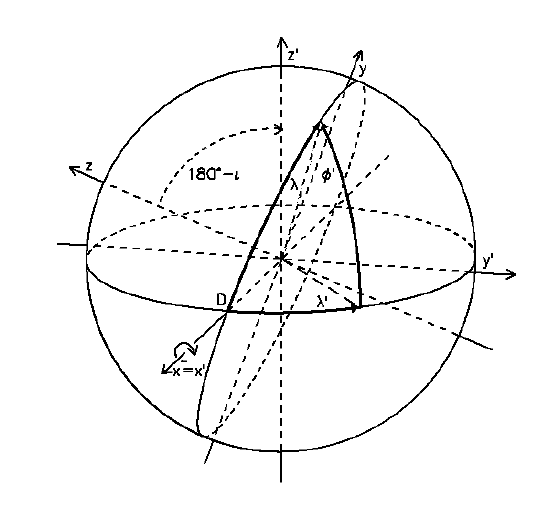
Figure 1. Rotation of coordinate system Σ around x axis with angle 180 o - ι into Σ’